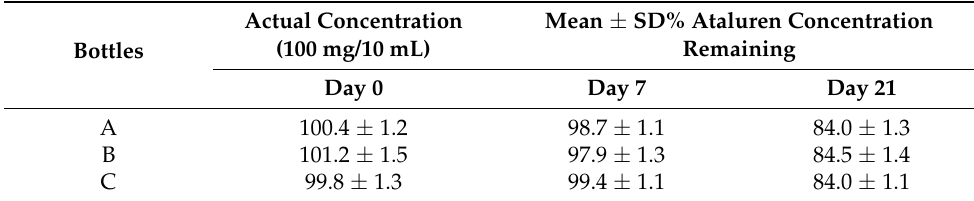
Table 5. Chemical stability of the STAR ataluren suspension eye drops (0.9% Sodium chloride,